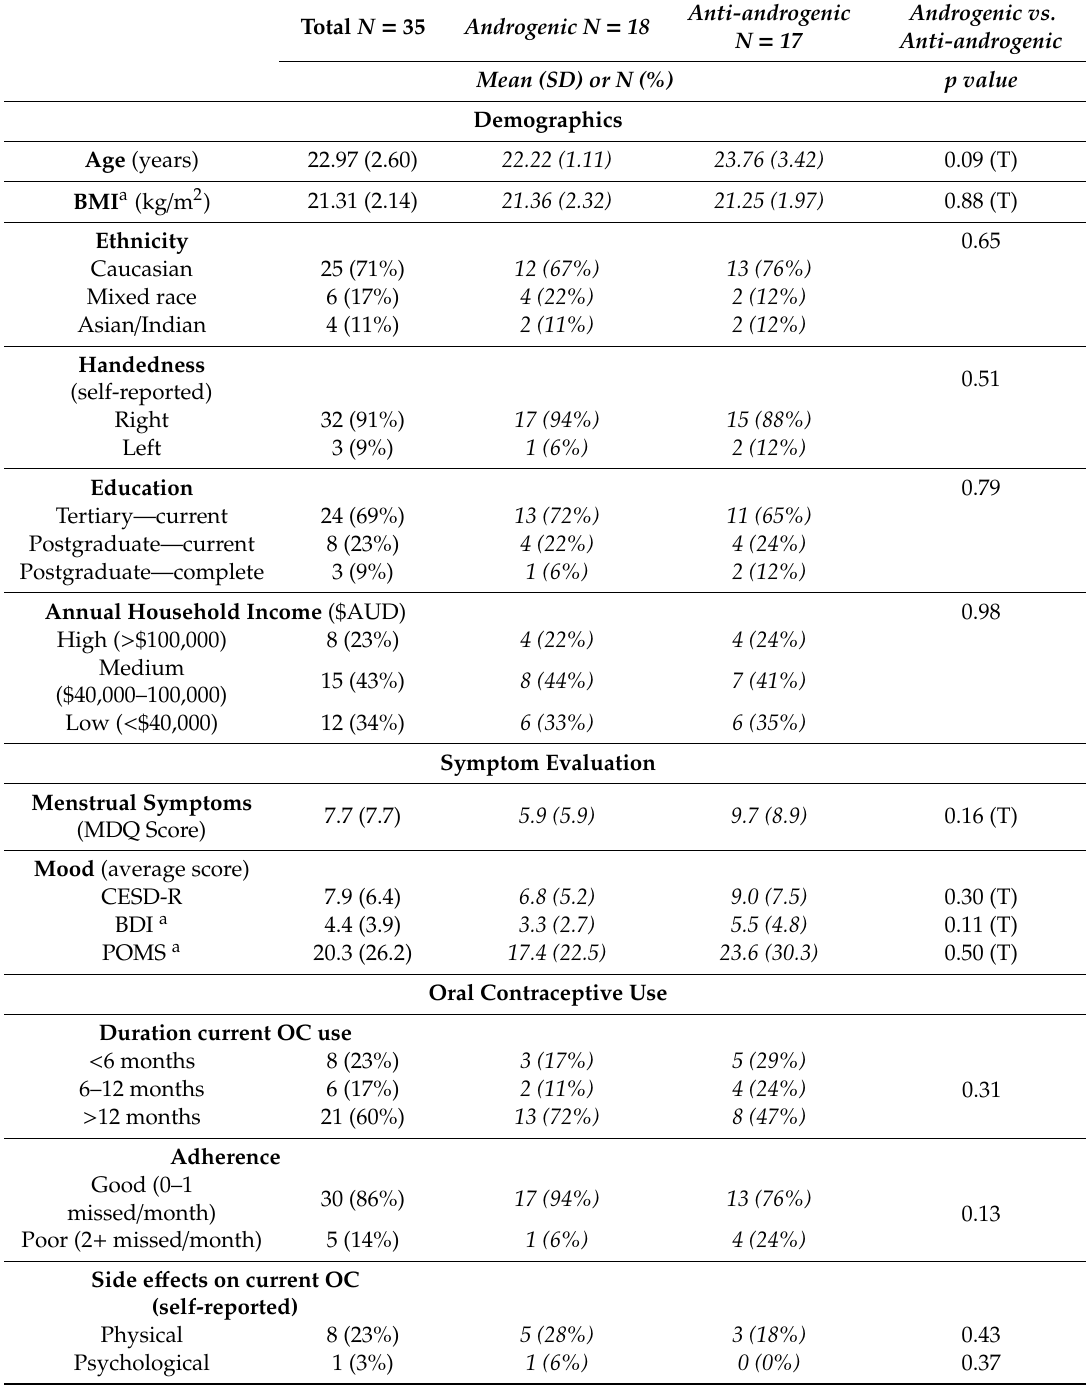
Table 3. Characteristics of study participants, including demographic variables, menstrual symptoms, mood scores, and OC use parameters, with comparison between androgenic and anti-androgenic OC user groups via chi-squared / T